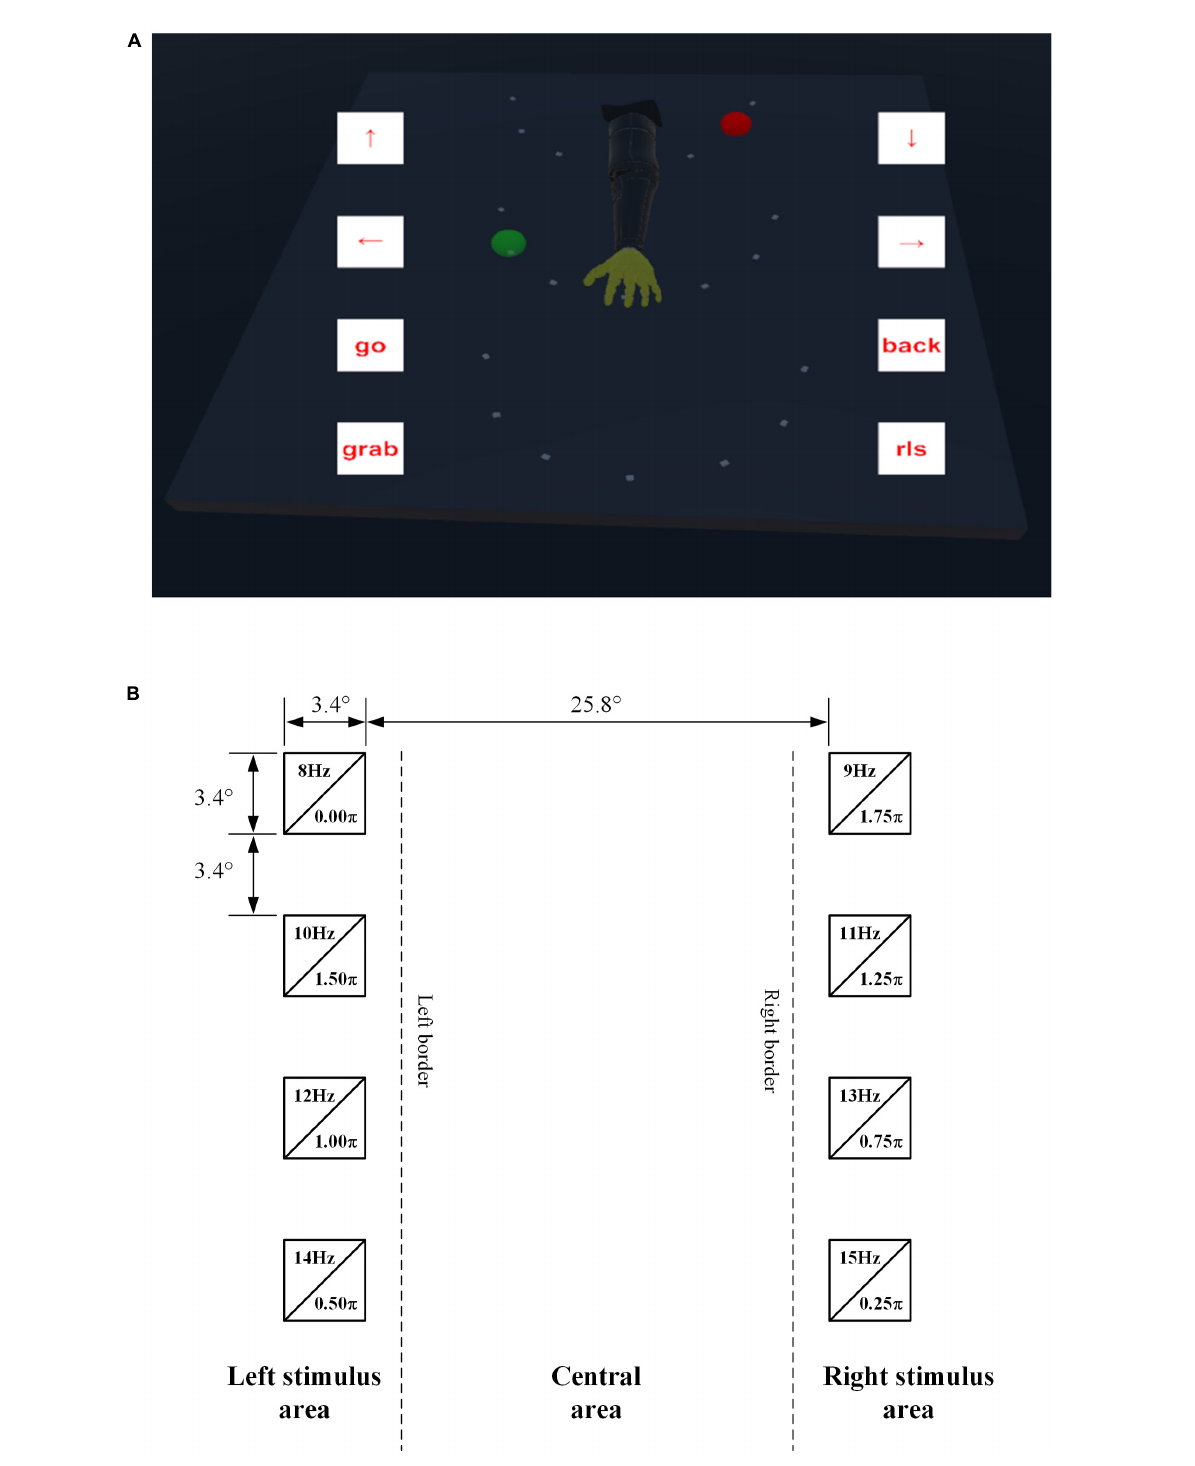
FIGURE2 (A) Diagram of virtual scene. (B) Flickering stimulus blocks.